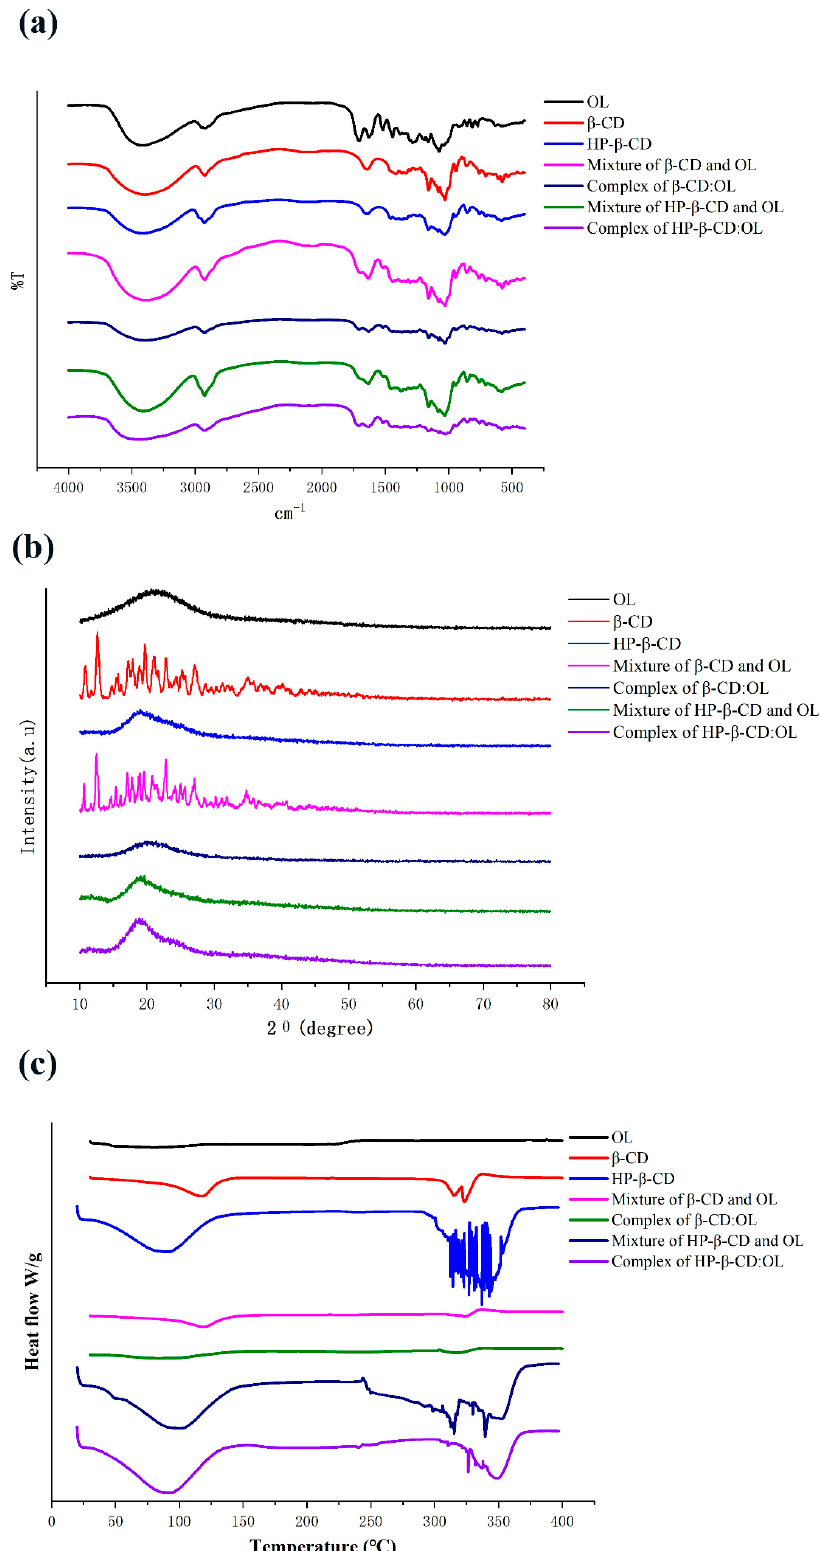
Figure 2. IR spectra ( a ), PXRD profiles ( b ), and DSC thermograms ( c ) of OL, beta-CD, HP-beta-CD, the physical mixture of beta-CD and OL, inclusion complex beta-CD:OL, the physical mixture of HP-beta-CD and OL, and inclusion complex HP-beta-CD:OL. The abbreviations are as Figure